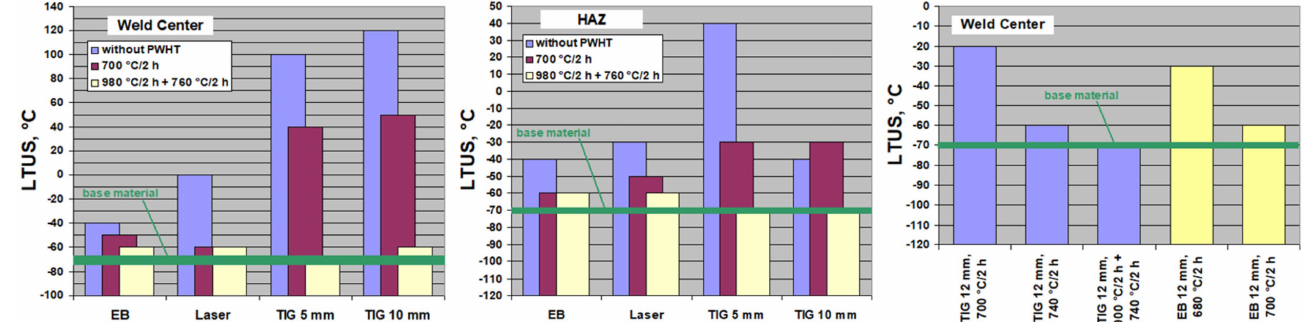
Figure 18. Lowest temperature in the upper shelf (LTUS) for 5 mm, 10 mm, and 12 mm welds after different post-welding heat treatments. The notches of the Charpy specimens were fabricated either in the weld center or in the HAZ (as indicated). For comparison, DBTT of the base material is plotted as a horizontal line in the